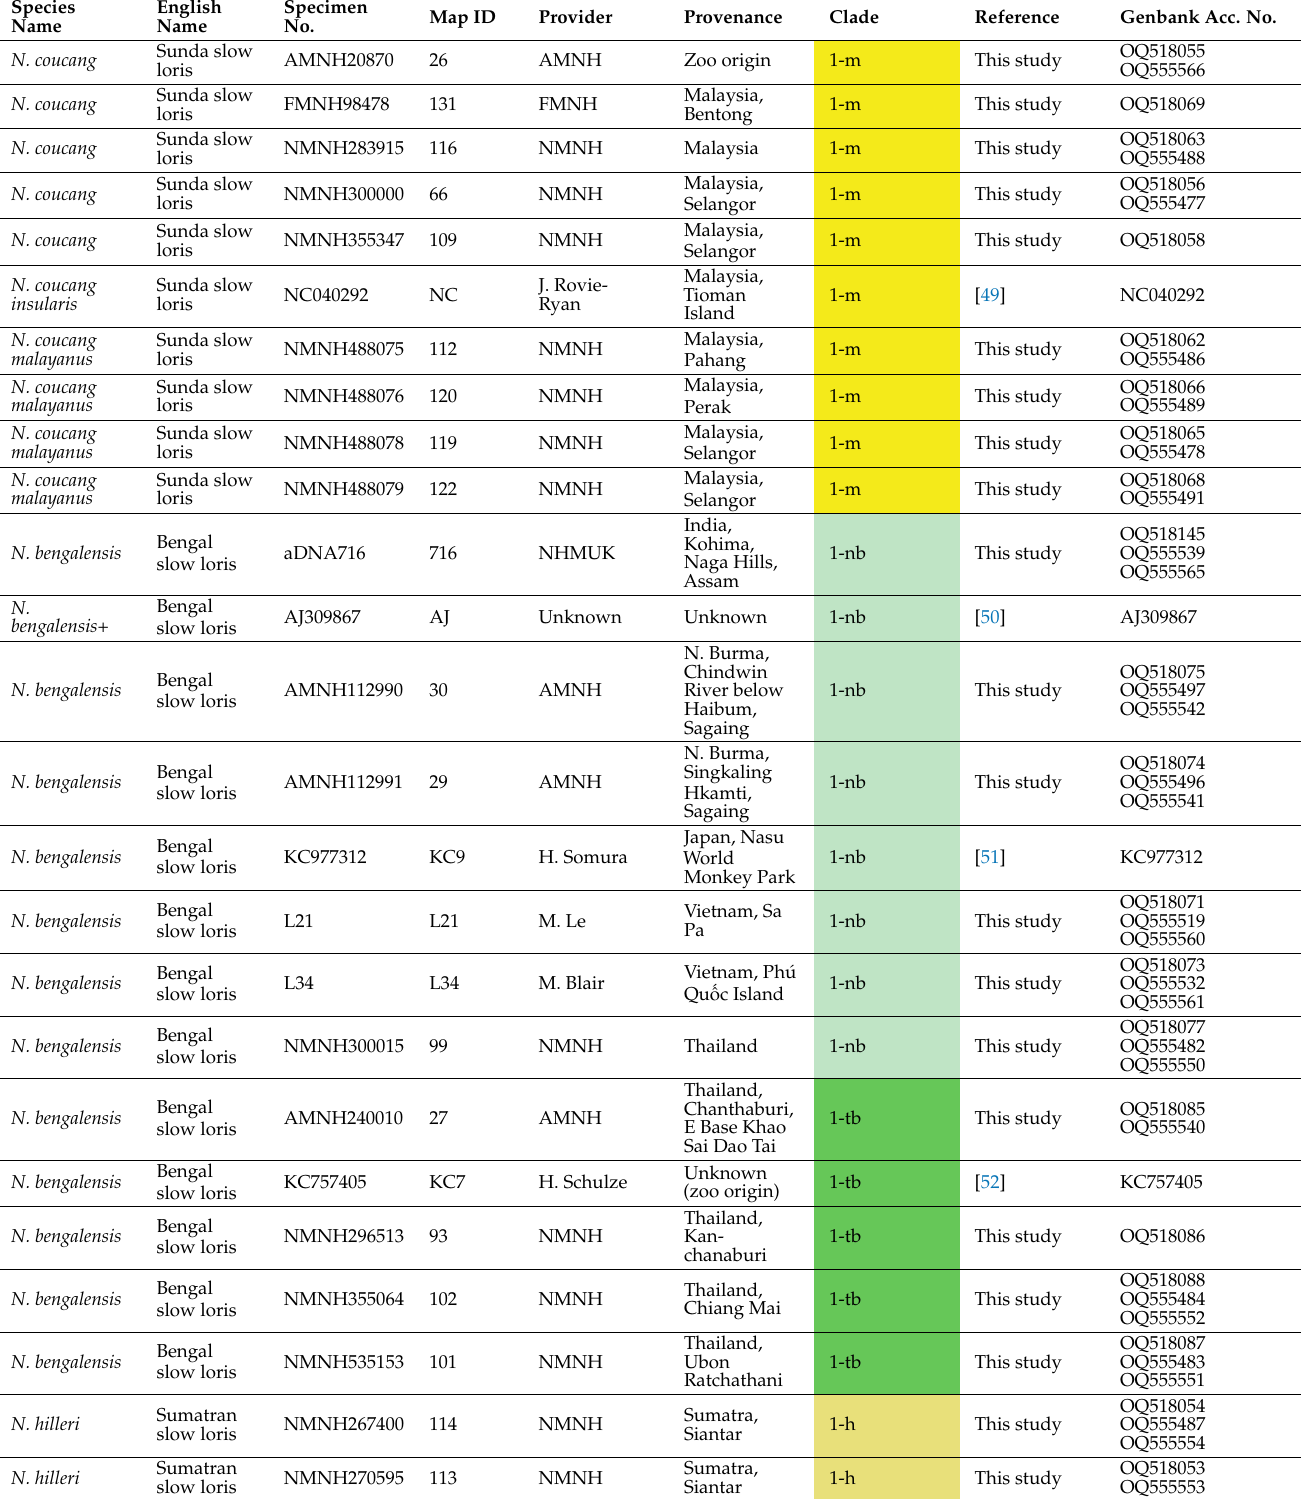
Table 1. Sample details, including GenBank accession numbers of mitochondrial sequences generated by or used in this